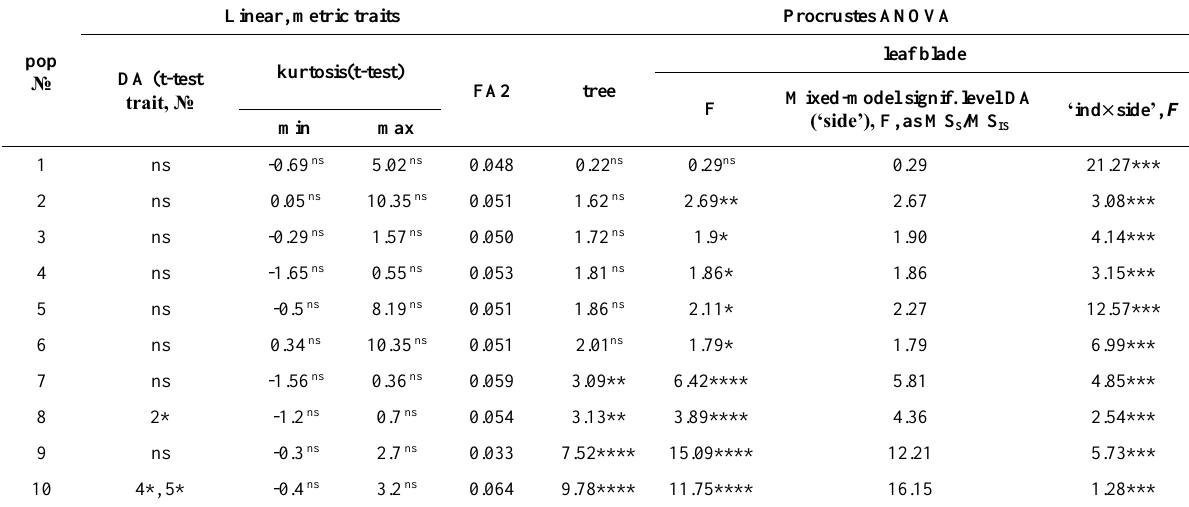
Table 3. Results linear measurement and